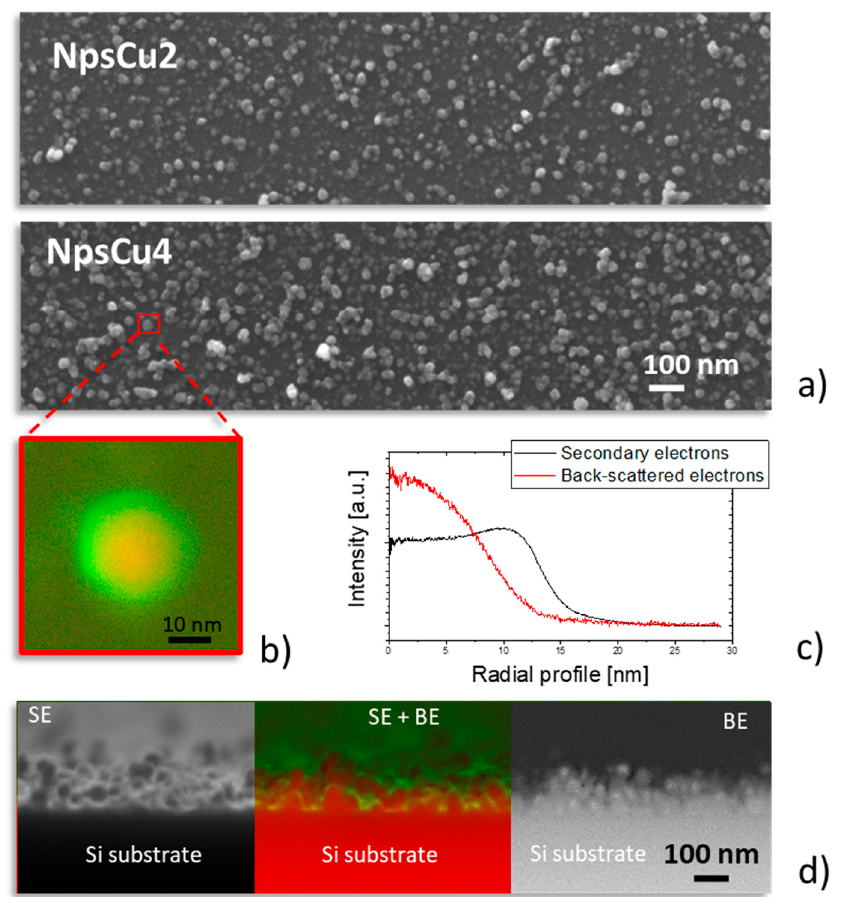
Figure 3. ( a ) Top-view SEM images of samples NpsCu2 and NpsCu4 measured in SE mode. ( b ) Composite SE (false green) and BE (false red) image of detail of surface nanostructure of sample NpsCu4 and ( c ) corresponding radial profiles. ( d ) Cross-section of NpsCu4 coatings measured in SE mode ( left ), BE mode ( right ) and composite SE and BE SEM image ( middle ).